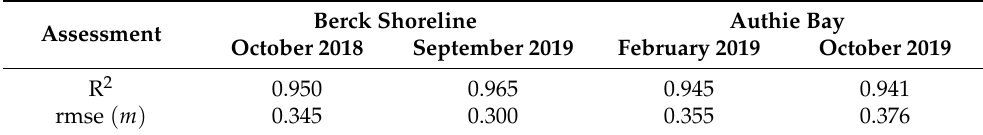
Table 3. Accuracy assessment of satellite-derived topography